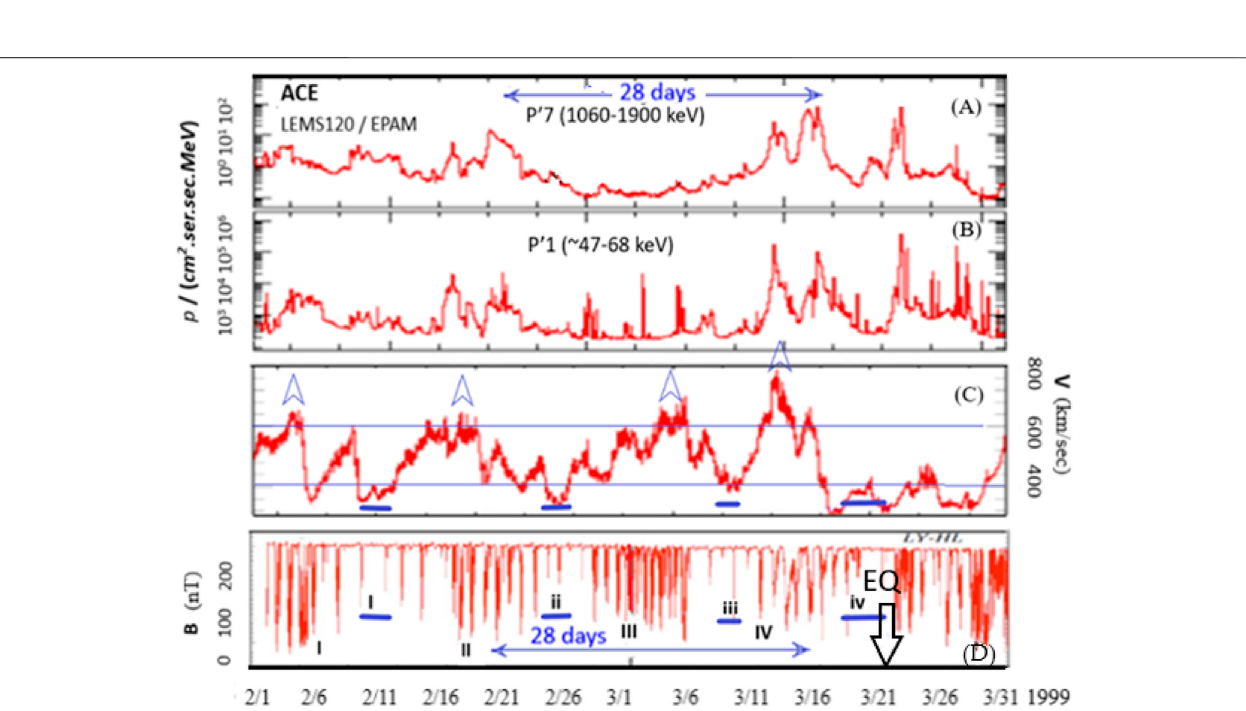
FIGURE 7 | From top to bottom: proton fl ux of low (ACE/LEMS120/P ’ 2) and high (ACE/LEMS120/P ’ 7) energy protons in the interplanetary space from the solar direction (A,B) ,solarwindspeed (A) ,and (D) themagnetic fi eld fl uctuations.Tests 5,6and 7arebasedonthecomparisonofsimultaneousmeasurementsobtainedby the ACE spacecraft in the interplanetary space and by the magnetic fi eld observatories in Taiwan for time long enough to cover at least two successive, about 28 days separated CIRs.